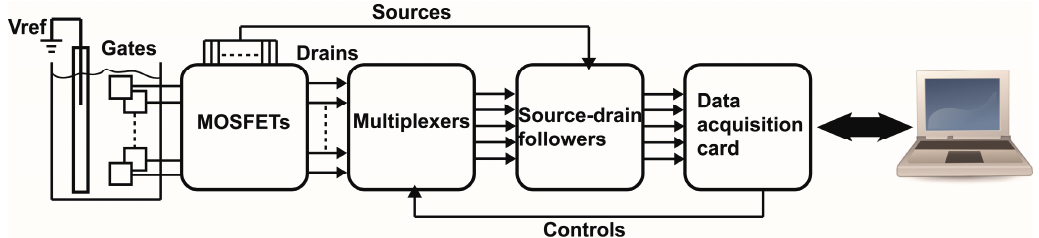
Figure 2. Overview of system architecture of the instrumentation used to evaluate the chemical